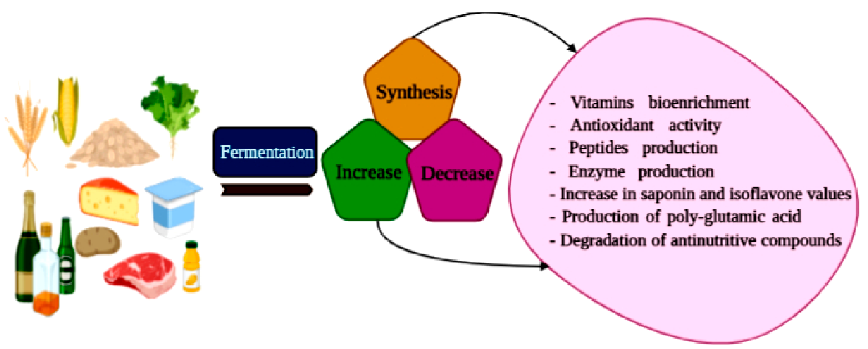
Figure 1. Nutritional enhancement in fermented foods; reproduced from Sharma et al. [10].